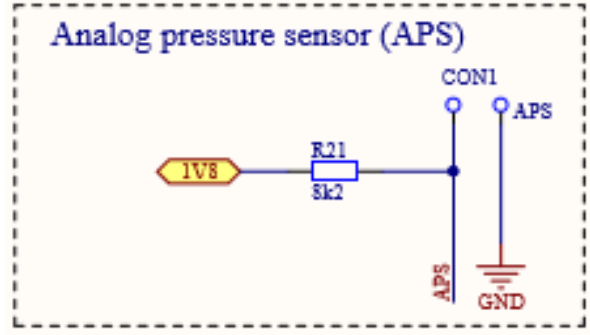
Figure 7. Analog sensor connector.